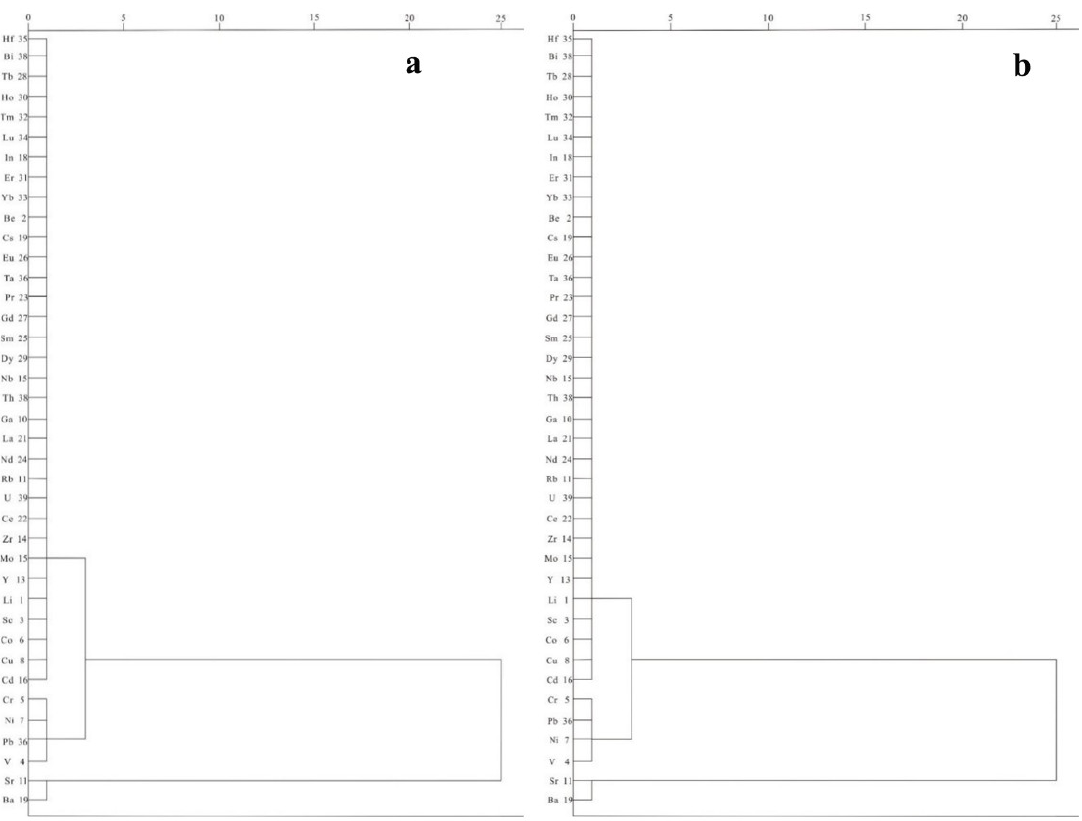
Figure 4. Pedigree diagram of element clustering in samples A ( a ) and A 1 ( b ).